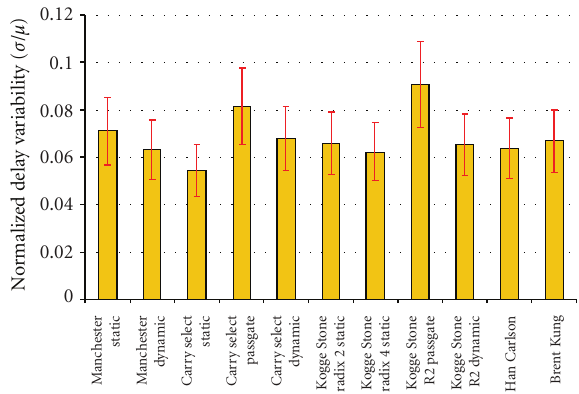
Figure 1: The delay variation for 16-bit adders in IBM Cu-08 tech- nology (courtesy of IBM).